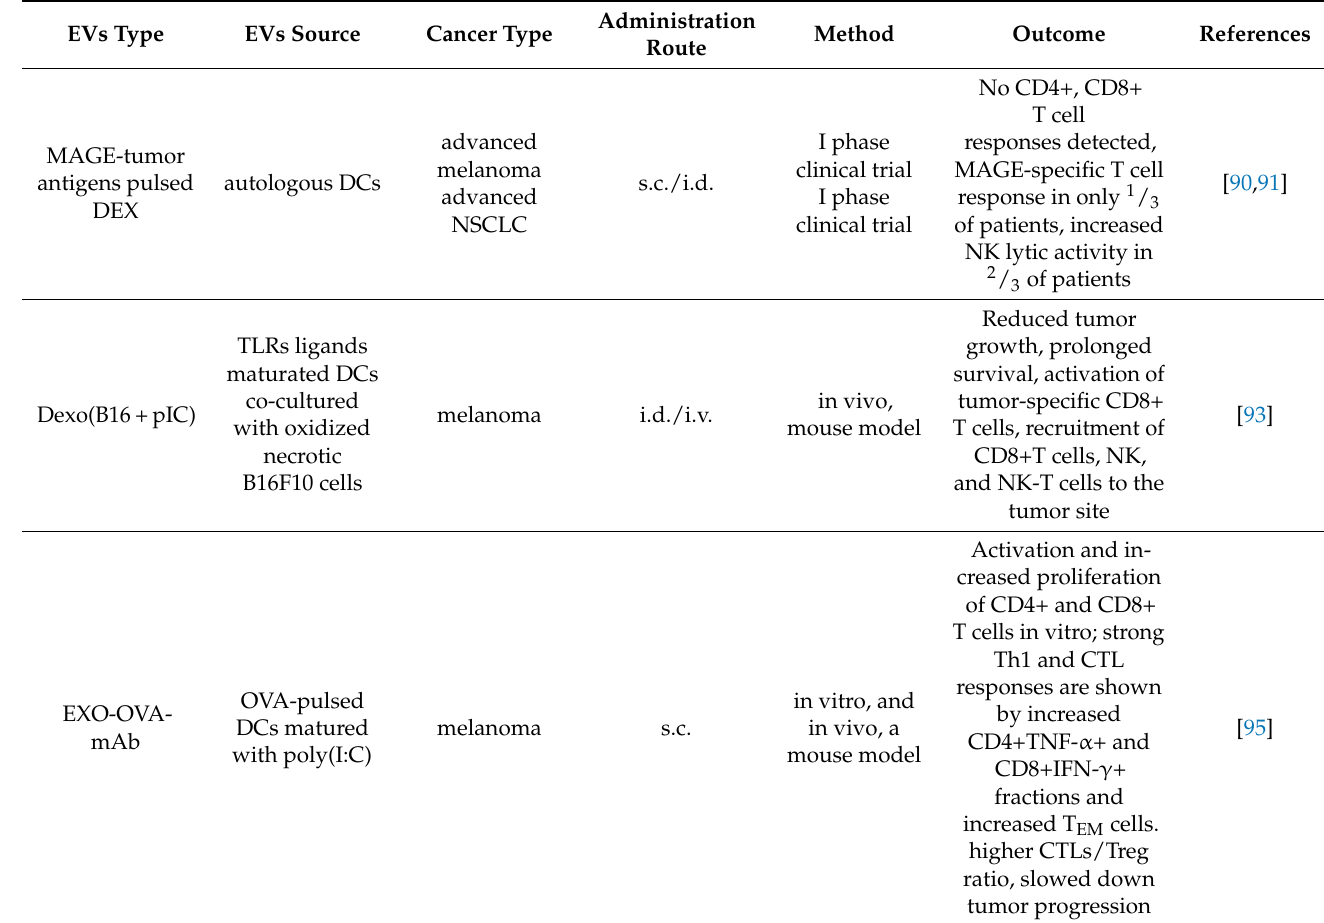
Table 2. Exosome-based cancer